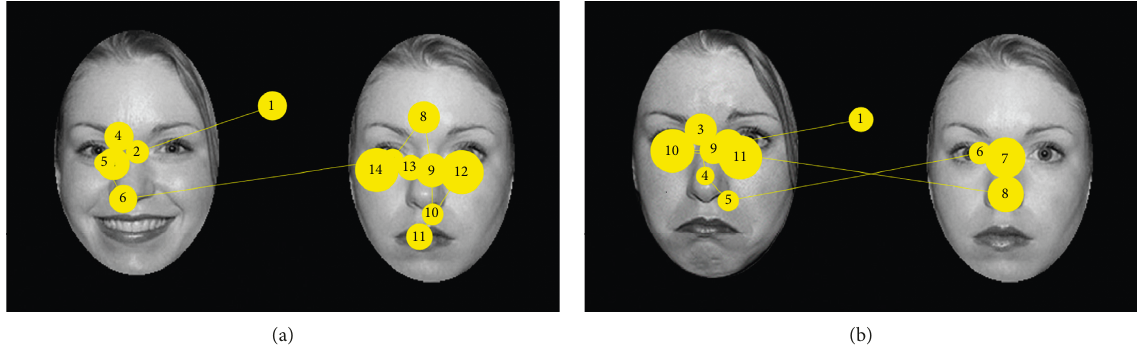
Figure 1: An example of eye movements when a depressed patient views (a) positive bias tasks and (b) negative bias tasks. Each circle represents a gaze point, and its size represents the length of fixation time.